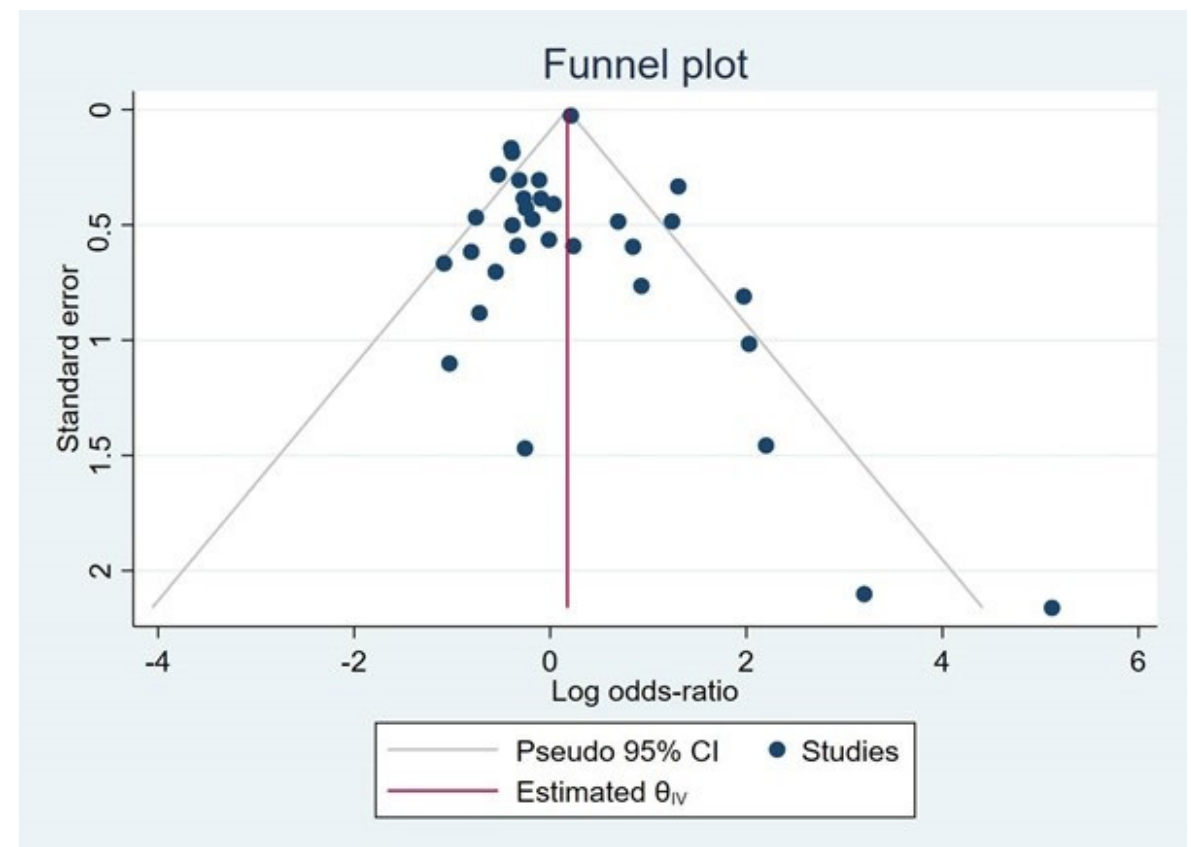
Figure 4. The funnel plot illustrated the unequal distribution of effect estimates on the graph. Ab ‐ breviations: CI, confidence interval; IV, inverse variance. Abbreviations: CI, confidence interval; IV, inverse